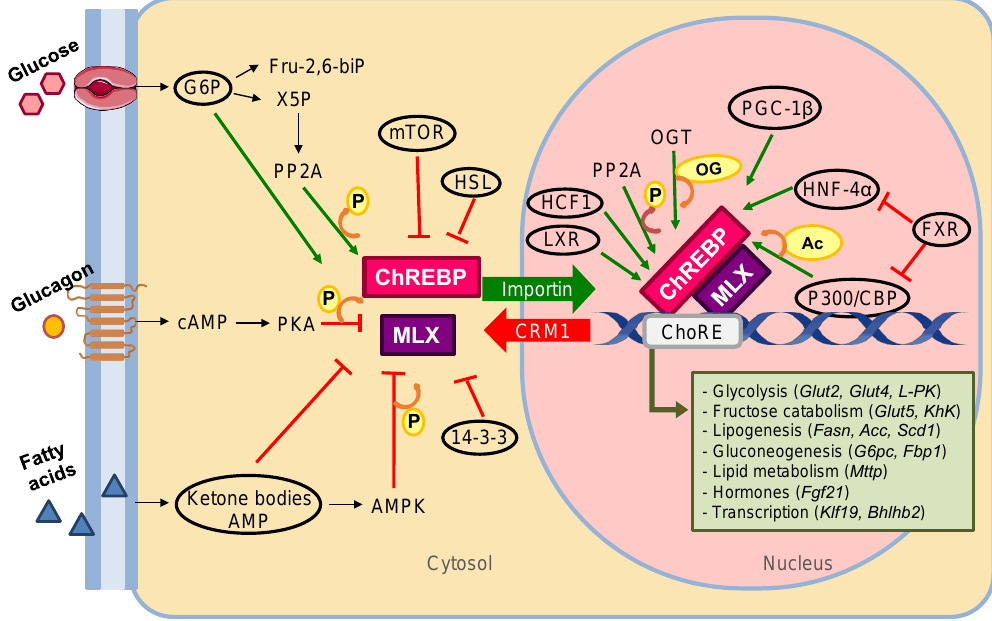
Figure 4. Regulation of nuclear translocation and transcriptional activity of ChREBP. Inactivated ChREBP is located in the cytosol due to phosphorylation by PKA and AMPK and the allosteric inhibition of mTOR, HSL, AMP or ketone bodies. In the presence of glucose, the metabolite G6P induces an active conformation of ChREBP and PP2A, activated by X5P, dephosphorylates it. Partially dephosphorylated ChREBP is translocated to the nucleus, where it undergoes several post-translational modifications important for its activity. The heterodimer ChREBP-MLX binds to several coactivators (such as LXR, HCF1, HNF-4α and p300/CBP, the latter two being repressed by FXR) in order to complete the active transcriptional complex. The proteins included in black circumferences have an allosteric effect, and the yellow circles represent the post-translational modifications of the residues (Ac: acetylation; OG: O-GlcNAcylation; P: phosphorylation). This figure was created with Servier Medical Art (https://smart.servier.com/, accessed on 20 August 2020) under a creative commons license (https://creativecommons.org/licenses/by/3.0/).